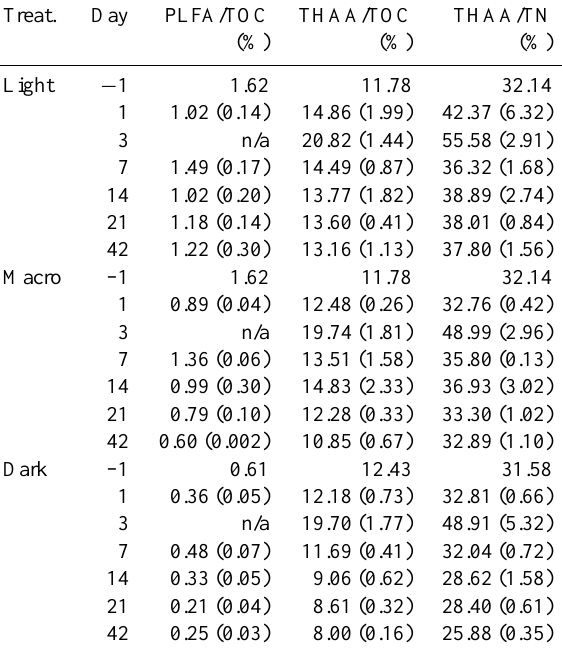
Table 4. The proportion (%) of PLFA/TOC, THAA/TOC and THAA/TN in sediments. Values are mean (SE). n = 4 for all except Day − 1 ( n = 1).